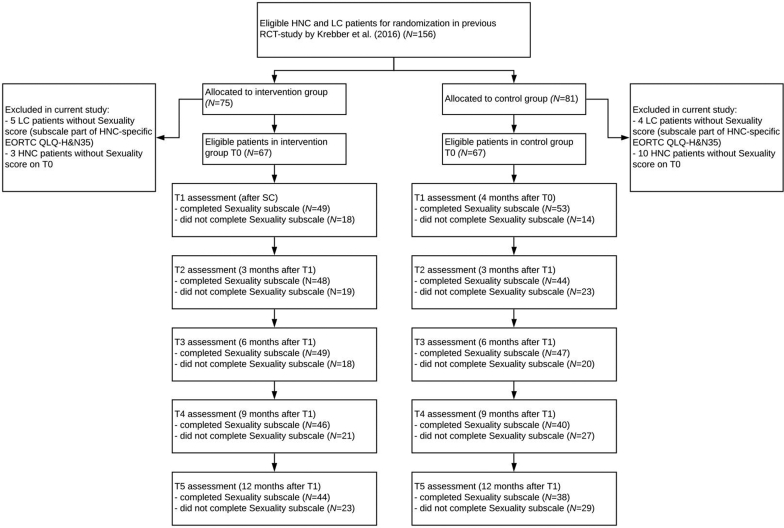
CONSORT flow diagram.